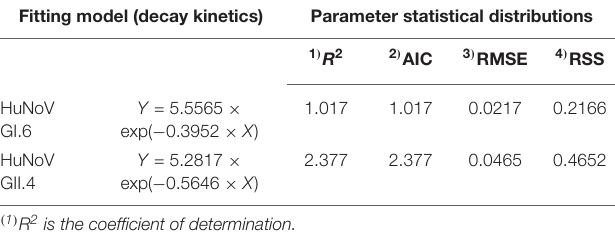
TABLE 1 | Analysis of SAEW decay kinetic models in terms of reduction values of HuNoVs based on cabbage-to-SAEW ratio. Fitting model (decay kinetics)